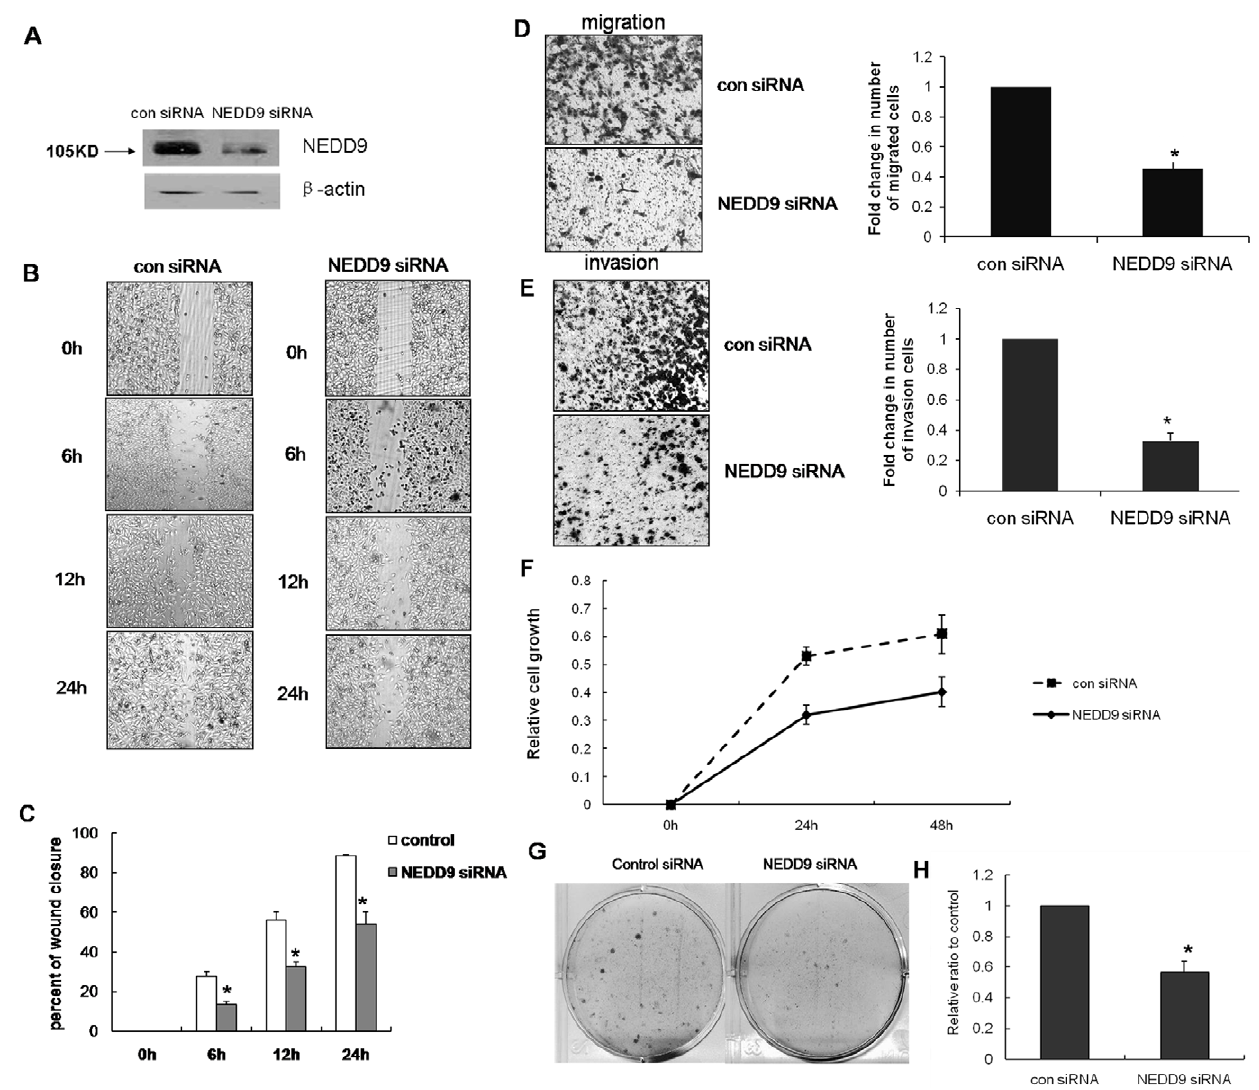
Figure 2. Suppression of NEDD9 expression inhibited tumor cell migration, invasion and proliferation. A, NEDD9 expression in NEDD9 siRNA-MDA-MB-231 cells. The level of NEDD9 in NEDD9 siRNA-MDA-MB-231 and control siRNA-MDA-MB-231 was determined by western blotting. B, C, Knockdown of NEDD9 inhibited MDA-MB-231 cell motility. Cells were plated for a scratch wound assay. Photographs were taken at 0, 6, 12 and 24 hr after wounding. The percentage of wound closure was calculated using Image J software. D, E, Migration and invasion assays using either control siRNA-MDA-MB-231 or NEDD9 siRNA-MDA-MB-231 cells. The migration and invasion ability is presented as fold change in number of cells migrated to the bottom chamber. Bars represent the mean SEM of samples measured in triplicate, and each experiment was repeated at least three times. F, Effect of NEDD9 on cell proliferation. MTT assay was used to estimate the proliferation at different time points. G, H, Effect of NEDD9 on colony formation. Cells were cultured in the presence of 1 mg/L G418 for 2 weeks. Colonies were stained with crystal